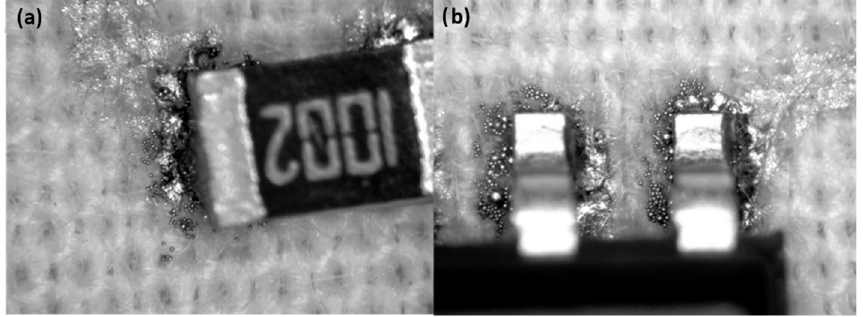
Figure 13. Soldering microscope pictures of 0805 ( a ) and SOIC8 ( b ) packages with solder paste Indium Indalloy #281.